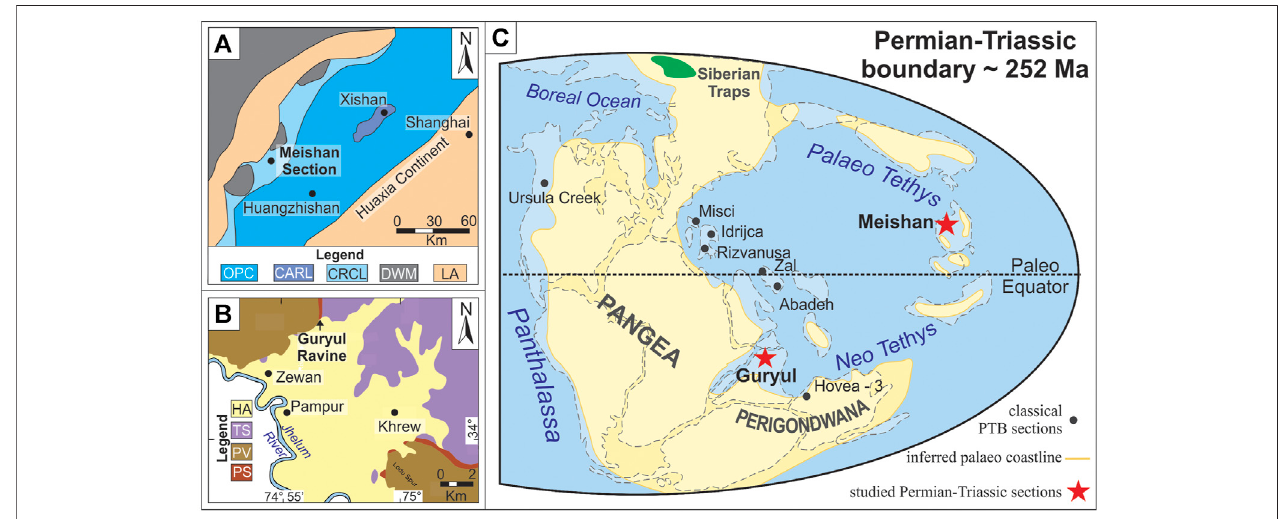
FIGURE 1 | (A) Late Permian paleogeographic map for the Meishan D (GSSP) section, China (based on Wu et al., 1983; Cao et al., 2010; Li and Jones, 2017). (B) GuryulRavinesection,Kashmir(modi fi edfromTewarietal.,2015)and (C) globalpalaeogeographicalreconstructionforthePermian – Triassictransitionandgeographical location of Meishan GSSP and Guryul Ravine sections (modi fi ed from Sial et al., 2020a). (A) OPC (cid:1) open platform carbonate, CARL (cid:1) calcareous algal reef limestone, CRCL (cid:1) carbonate ramp cherty limestone, DWM (cid:1) deep-water mudstone, LA (cid:1) land area. (B) HA (cid:1) Holocene alluvium, TS (cid:1) Triassic strata, PS (cid:1) Permian strata, PV (cid:1) Panjal